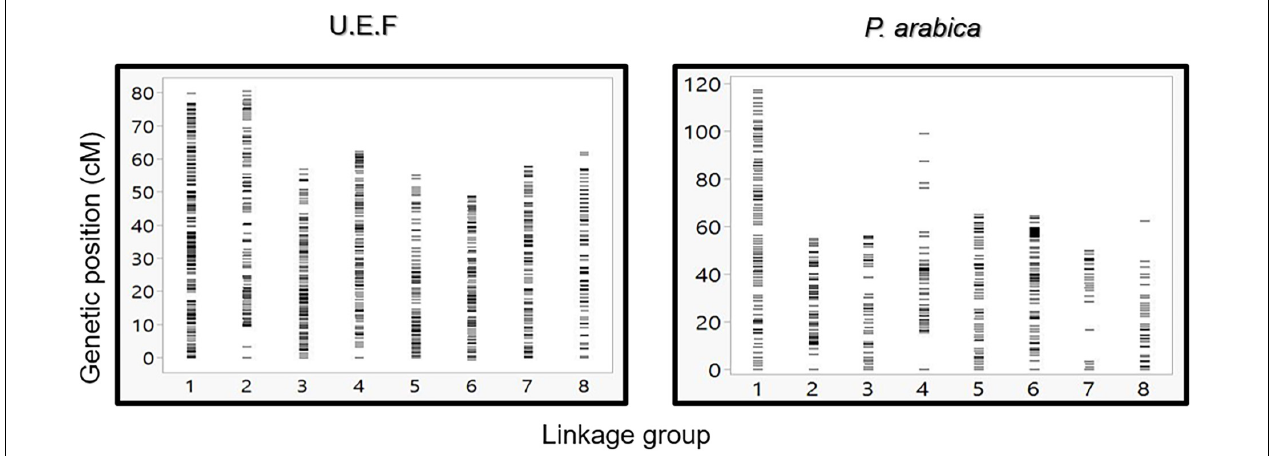
FIGURE 4 | Graphic presentation of markers density and distribution along the eight linkage groups. Comparison between U.E.F. map (left graph) and P. arabica map (right graph). Each horizontal line represents a single